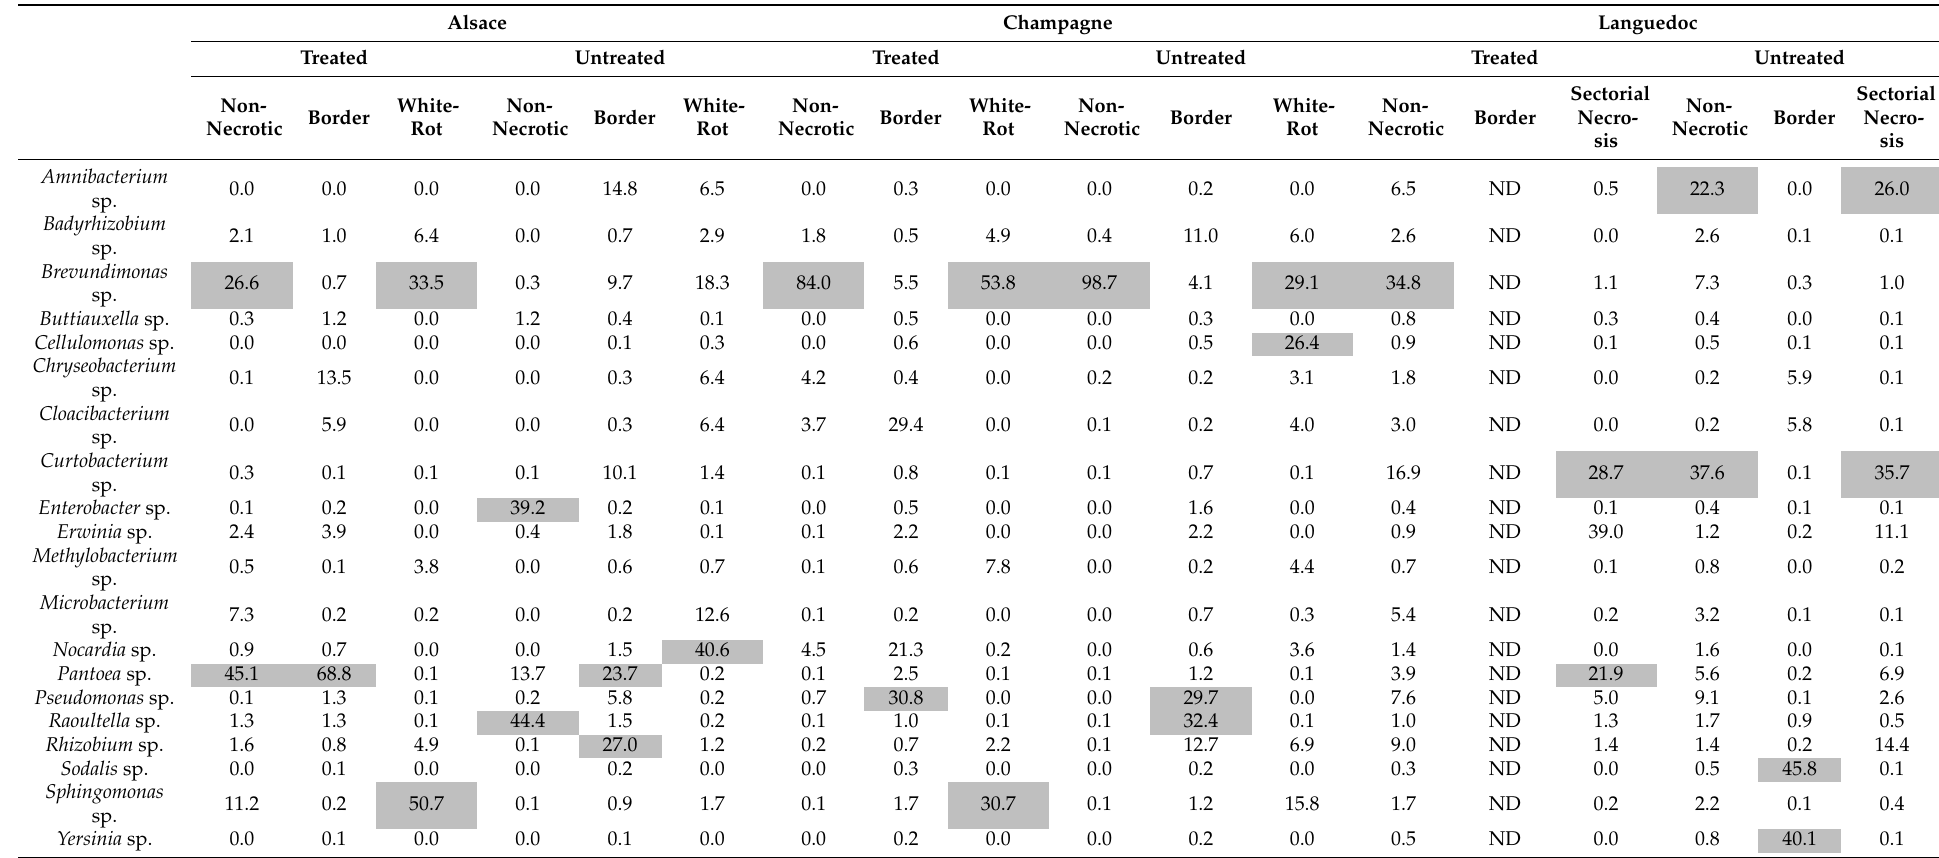
Table 4. The 20 most abundant bacterial taxa identified in woody tissue of grapevines from AlScheme 10. ND: not done. Alsace Champagne Languedoc Treated Untreated Treated Untreated Treated Untreated Sectorial Sectorial Non- White- Non- White- Non- White- Non- White- Non- Non- Border Border Necro- Border Border Border Border Necrotic Rot Necrotic Rot Necrotic Rot Necrotic Rot Necrotic Necrotic sis